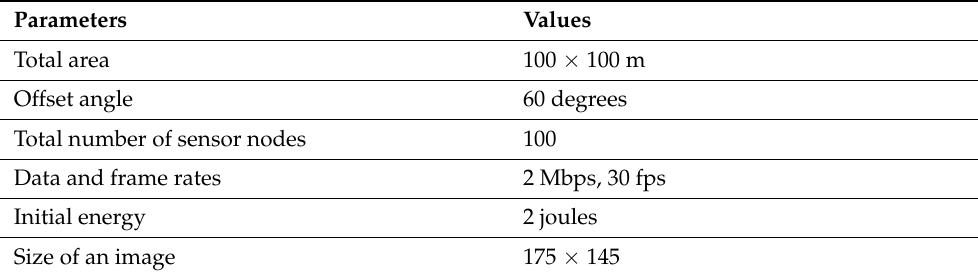
Table 3. Parameters employed for